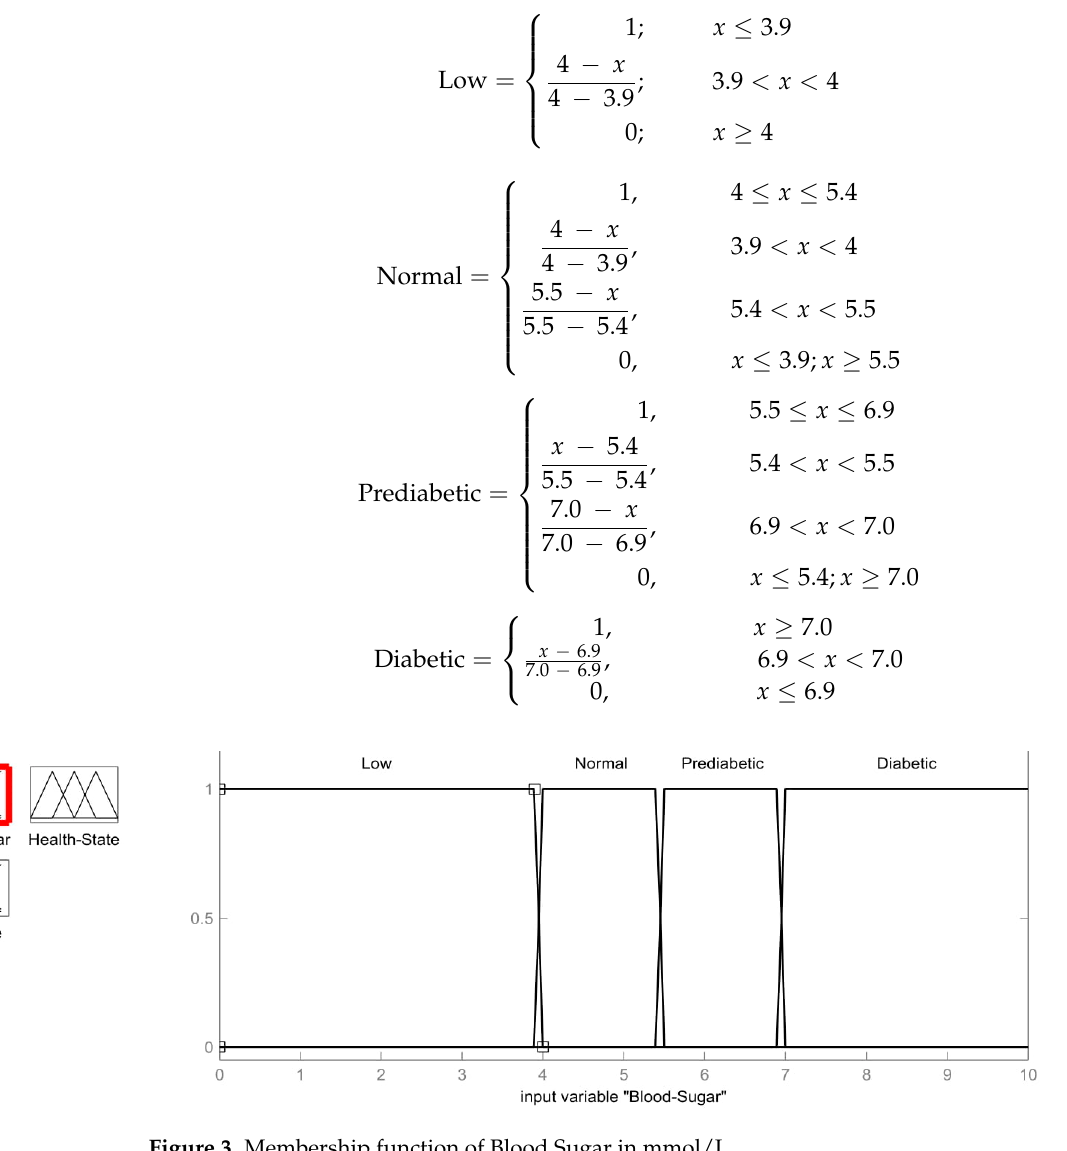
Figure 3. Membership function of Blood Sugar in